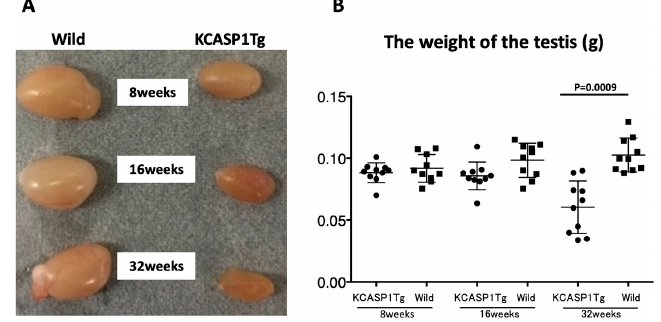
Figure 2. Clinical picture and weight of the testis. Testis size was smaller in KCASP1Tg mice than in wild ‐ type mice and was dependent on the age. The color was dark orange for 16 and 32 weeks age of KCASP1Tg mice ( A ). Testis weight was compared between KCASP1Tg mice and their littermate controls, which was lower in KCASP1Tg mice than in wild ‐ type mice with significance at the age of 32 weeks ( p = 0.0009, B ).